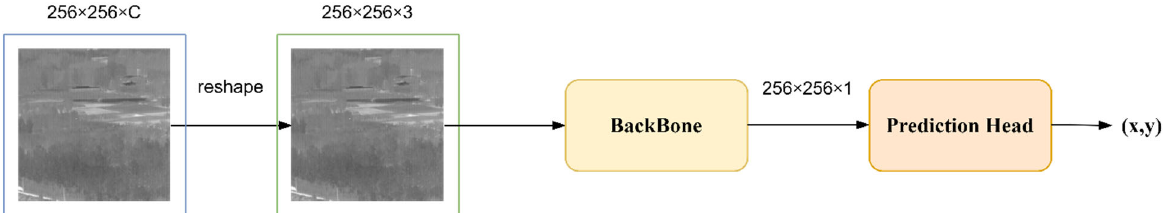
Figure 1. The structure of DRUNet is shown in the figure. The image of arbitrary size W × H × C is reshaped to 256 × 256 × 3 and input to the backbone network for feature extraction, becoming a feature map of the size 256 × 256 × 1. Finally, the target center point coordinates are output through the prediction head.